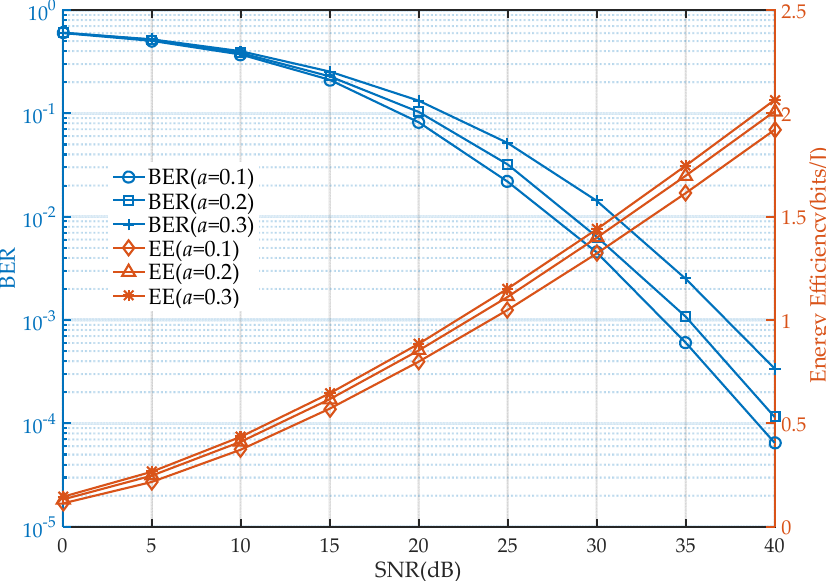
Figure 5. EE performance of networks under different user selections ( P s = 10, a = 0.2, ρ = 0.6).